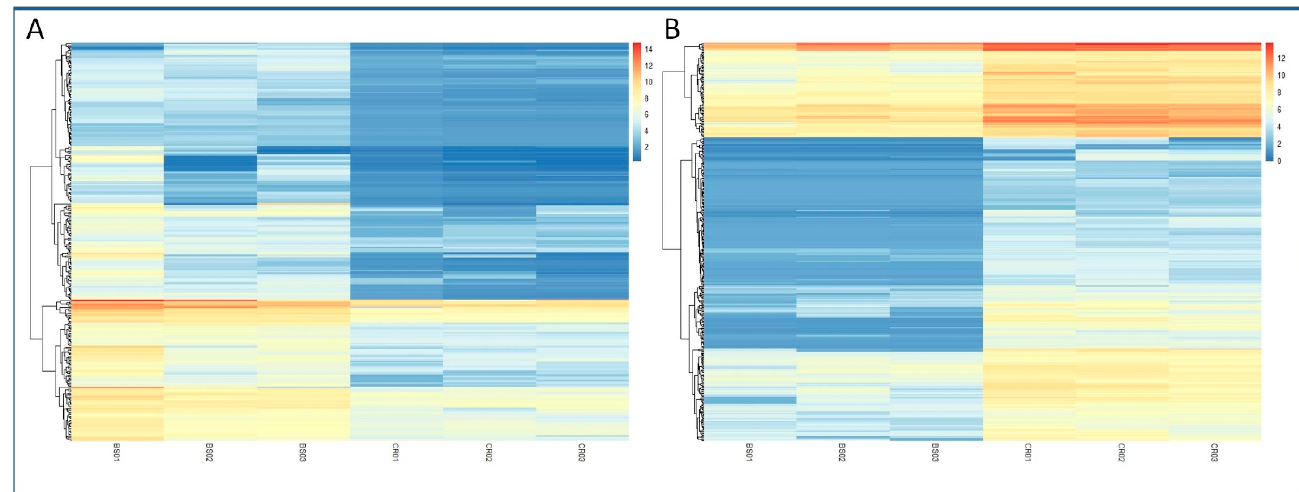
Figure 2. Heatmaps of the expression of DEGs detected in the differential analysis. Level of expression is shown as the log2FC of the transformed count data from the transcriptomics analysis. Different columns in the figure represent different samples, and different rows represent different genes. The colors from blue to red indicate increasing levels of expression. ( A ) Expression of DEGs detected in the BS samples. ( B ) Expression of DEGs detected in the CR samples.